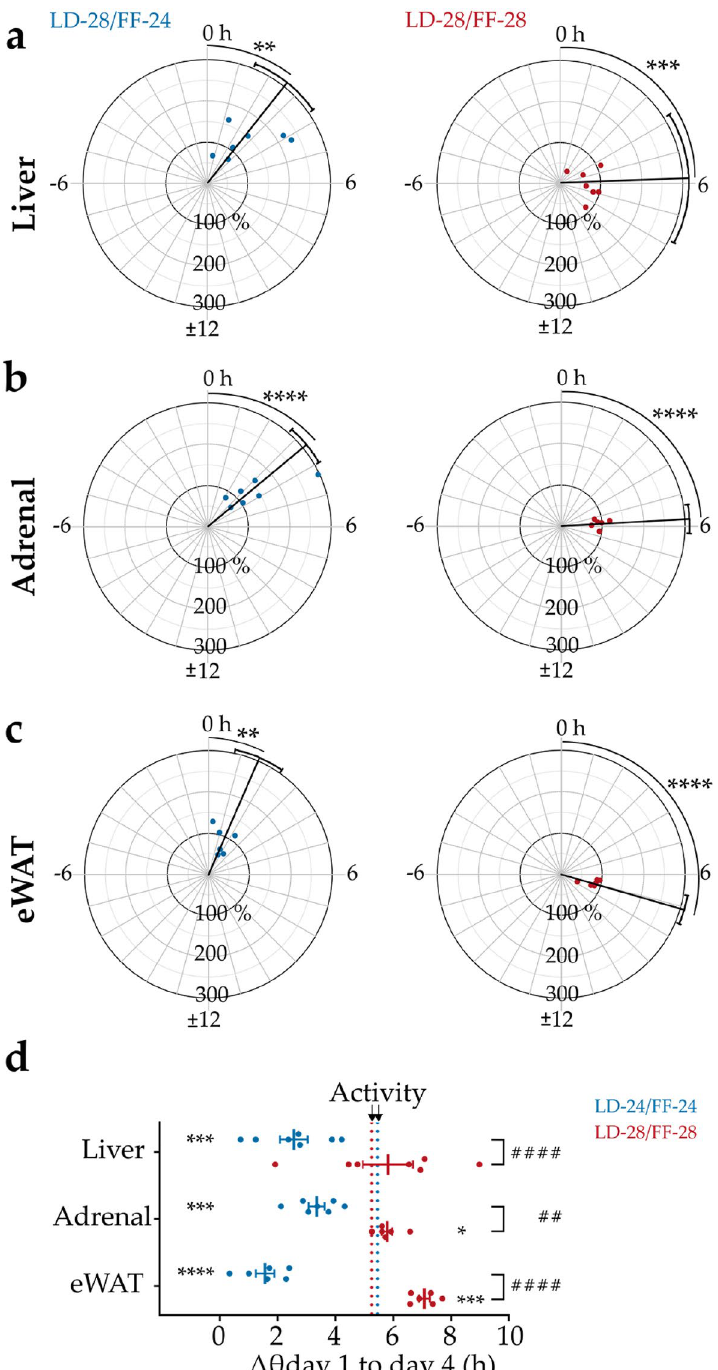
Figure 3. Phase and amplitude effects of clock gene expression rhythms between day 1 and 4 under LD-28/ FF-24 and LD-28/FF-28 conditions. Phase shifts of clock gene peak expression calculated from sine fit maxima for LD-28/FF-24 (blue) and LD-28/FF-28 (red) conditions in ( a ) liver, ( b ) adrenal, and ( c ) eWAT. Phase shifts (in hours) and normalised amplitudes relative to baseline (in % of baseline) are shown on radial and axial axes, respectively. Black lines indicate mean phase shifts ± 95% confidence intervals. n = 6–7; ** p < 0.01, *** p < 0.001, **** p < 0.0001; one-sample t-test against 0 h phase shift. ( d ) Phase shifts of clock gene expression peaks between day 1 and day 4. Mean activity shifts are indicated by dotted vertical lines. Data are shown as means ± SEM; n = 6–7; ## p < 0.01, #### p < 0.0001 phase angle difference between feeding regimes; two-way ANOVA with Sidak’s post-tests; * p < 0.05, *** p < 0.001, **** p < 0.0001 phase angle difference between phase shifts of clock gene expression rhythms and mean phase shifts observed for activity onsets within one feeding